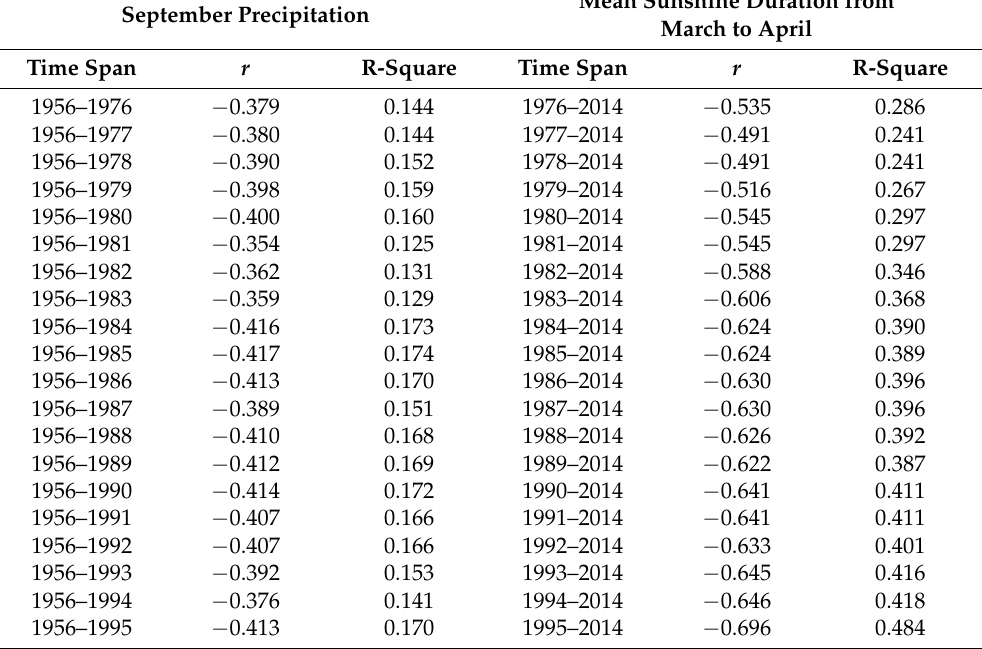
Table 1. Linear regressions between tree-ring chronology and climate factors (precipitation of September and mean sunshine duration from March to